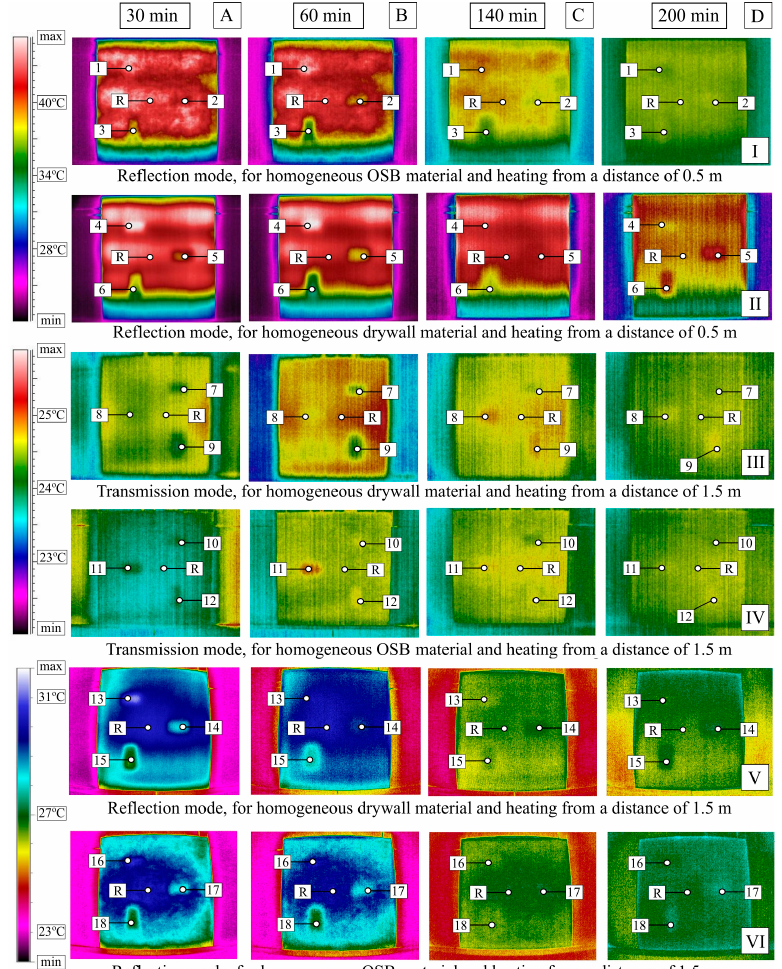
Figure 3. Thermograms at selected instants (time from the beginning of the tested element cooling down is specified above the figure). Numbers from 1 to 18 indicate the temperature reading position at the center of the cross section with a defect, while “R” designates the temperature reading position at the defect-free cross section.